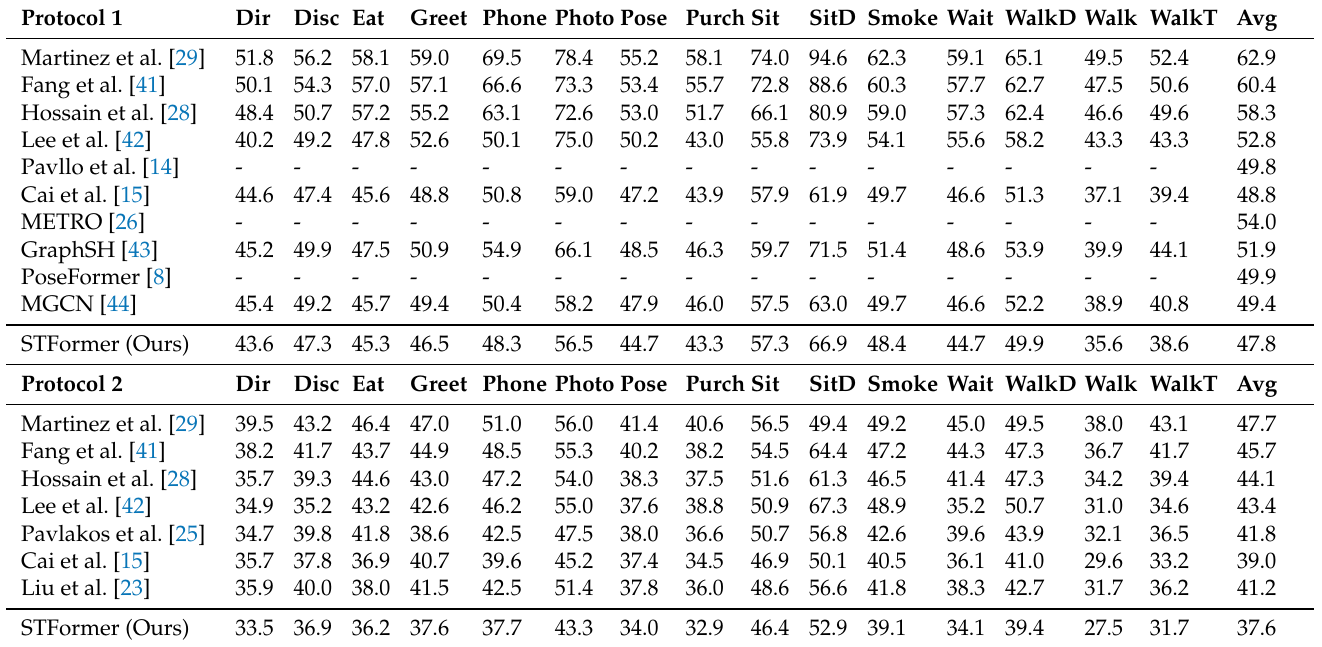
Table 1. Comparison of our method with previous methods on Human3.6M under Protocol 1 (top table) and Protocol 2 (bottom table) using the CPN-detected 2D pose as the input.